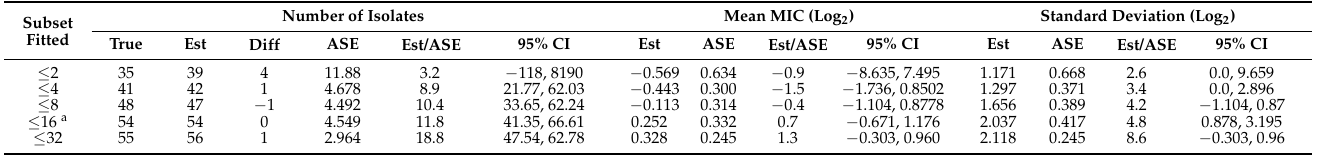
Table 2. Optimum non-linear least squares regression fitting of pooled MICs ( µ